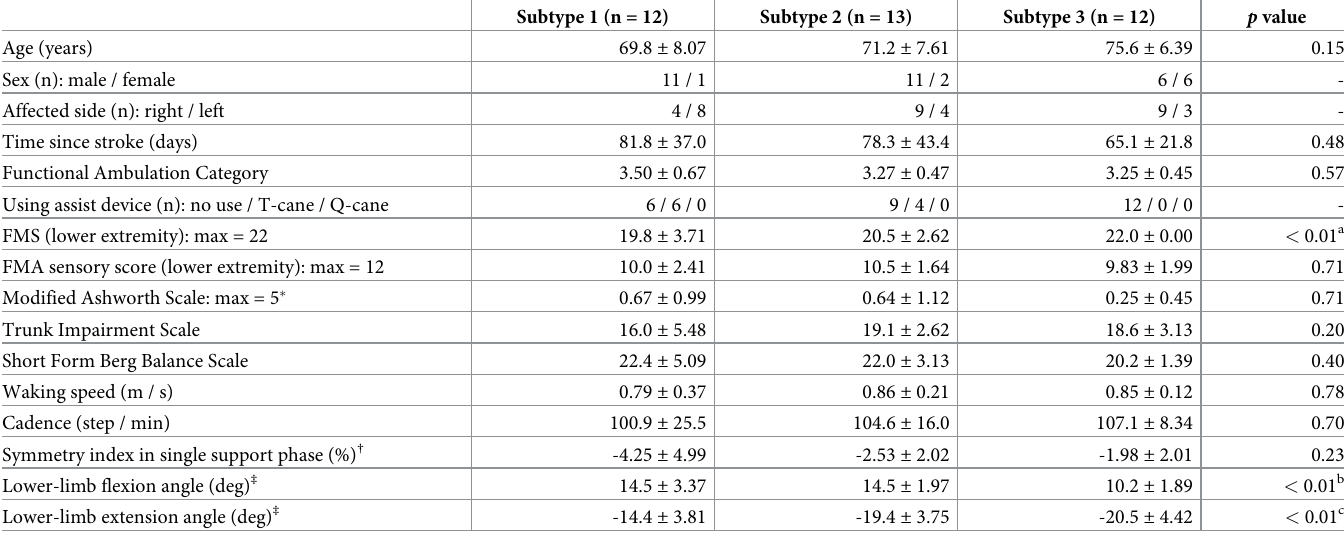
Table 1. Characteristics of each